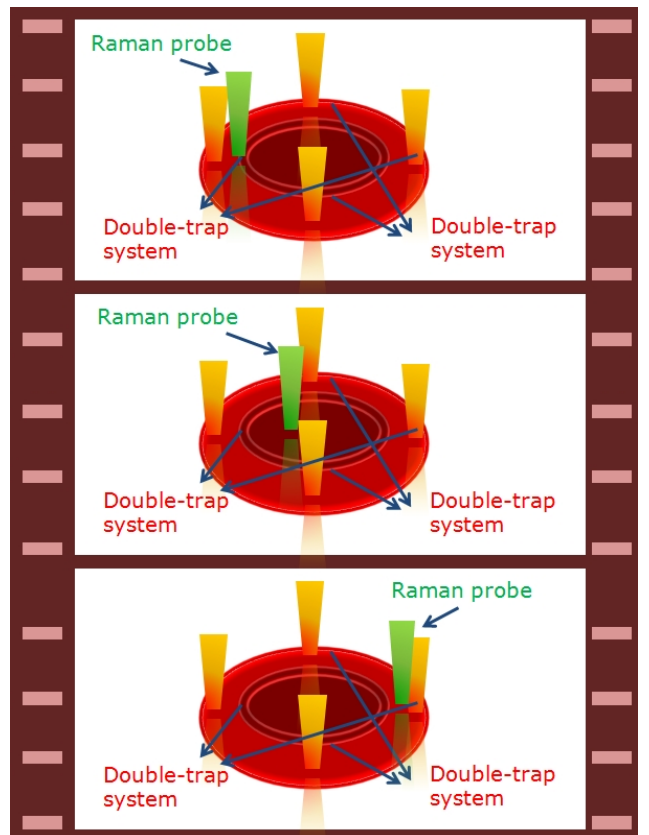
Figure 2. Schematic of the experimental method used for Raman imaging: the four-trap systems fixed the RBC in four points. By applying an offset signal to the galvo-drivers it was possible to scan the sample across the Raman